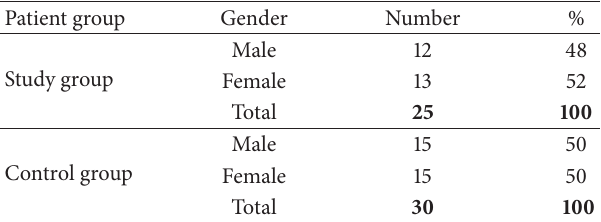
Table 1: Distribution of the groups by gender.